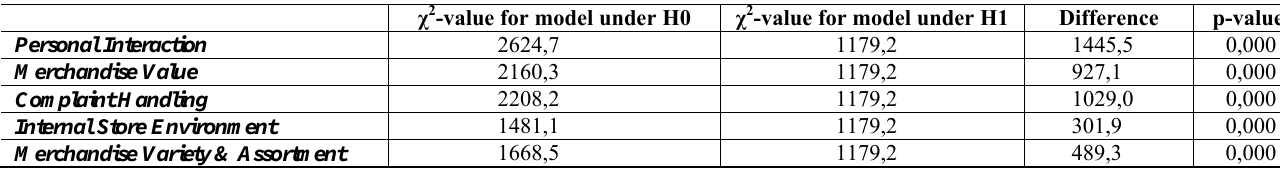
Table 12: Discriminant validity results: Sample 2